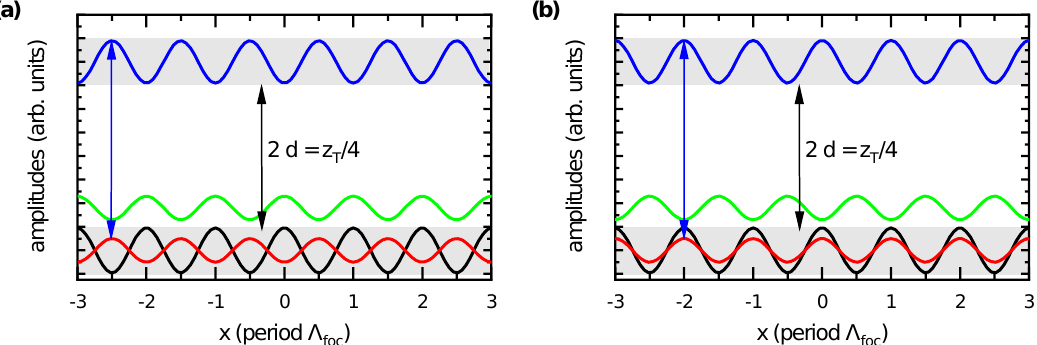
Figure 6. Illustration of feedback loop for single-mirror feedback for optomechanical interactions (see caption of Figure 2 for general explanation). Black line in atomic cloud denotes atomic density. ( a ) Blue detuning ( ∆ > 0): Atoms are low field seekers and hence atomic and intensity structures are complementary (atomic troughs align with intensity peaks, situation of experiment described in [44]). ( b ) Red detuning ( ∆ < 0): Atoms are high field seekers and hence atomic and intensity structures are aligned. Note that the nonlinearity is self-focusing also for red and blue detuning and the instability exists for both signs of the detuning (similar to [75] for the case of single-pass